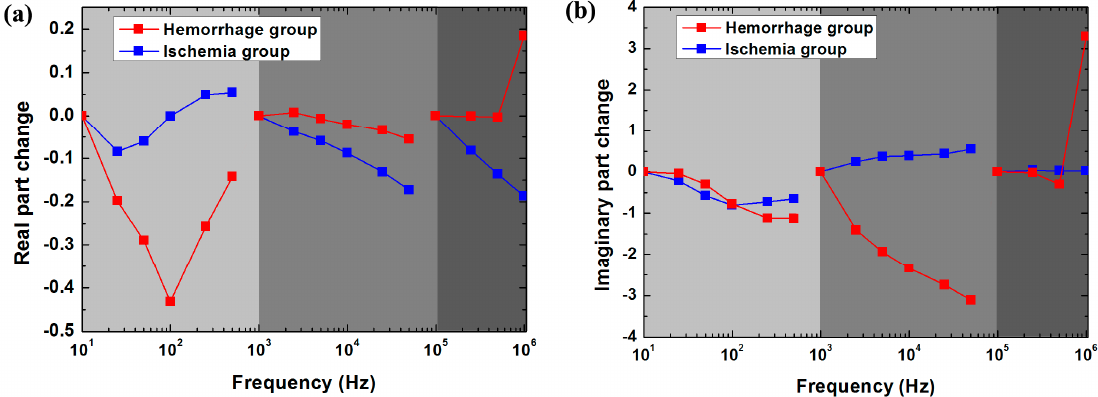
Figure 6. The rate of change in the real ( a ) and imaginary ( b ) parts of brain impedance after hemorrhagic and ischemic stroke in the low (10 Hz–1 kHz; reference frequency: 10 Hz), intermediate (1–100 kHz; reference frequency: 1 kHz) and high frequency (100 kHz–1 MHz; reference frequency: 100 kHz) ranges, as obtained from ∆ Z = ∆ Z real + j ∆ Z imag = Z after − Z before , where Z before and Z after represent brain electrical impedance before and after stroke, respectively.